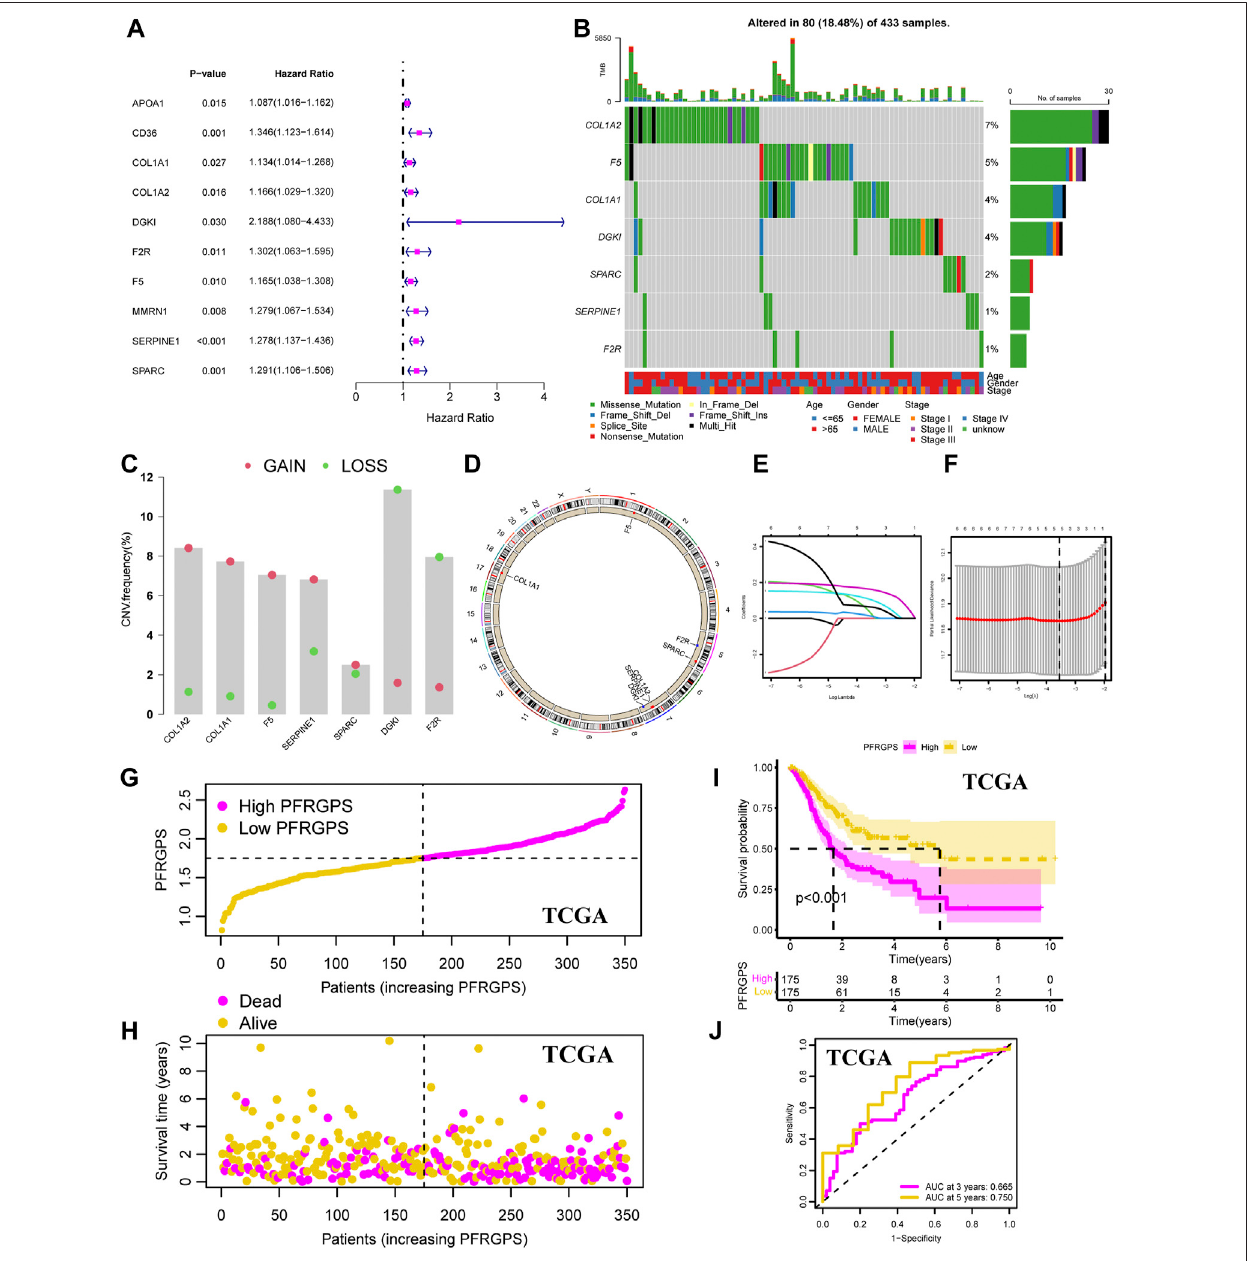
FIGURE3| DevelopmentofthePFRGPSSystem. (A) Theforestplotof10PPFGsmarkerswasobtainedbyunivariableCoxanalysis. (B) Thewaterfallplotofseven PPFGsmutations. (C) Gain(red)orloss(green)CNVsofGCpatients. (D) ThelocationandCNVsofsevenPPFGs. (E) LASSOcoef fi cientpro fi lesofsevenPPFGs. (F) The tuning parameters were cross-validated in the LASSO model. (G) Distribution of PFRGPS in TCGA cohort. (H) Survival status in the high-PFRGPS and low-PFRGPS subgroups of the TCGA cohort. (I) Kaplan-Meier survival analysis in TCGA cohort. (J) The ROC curve analysis according to the 3- and 5-year survival of the AUC value in the TCGA cohort. PFRGPS, platelet function-related genes prognostic score; PPFGs, prognosis-related platelet function-related genes; CNVs, copy number variations; LASSO, Least Absolute Shrinkage and Selection Operator; ROC, receiver operating characteristic; AUC, area under the curve.